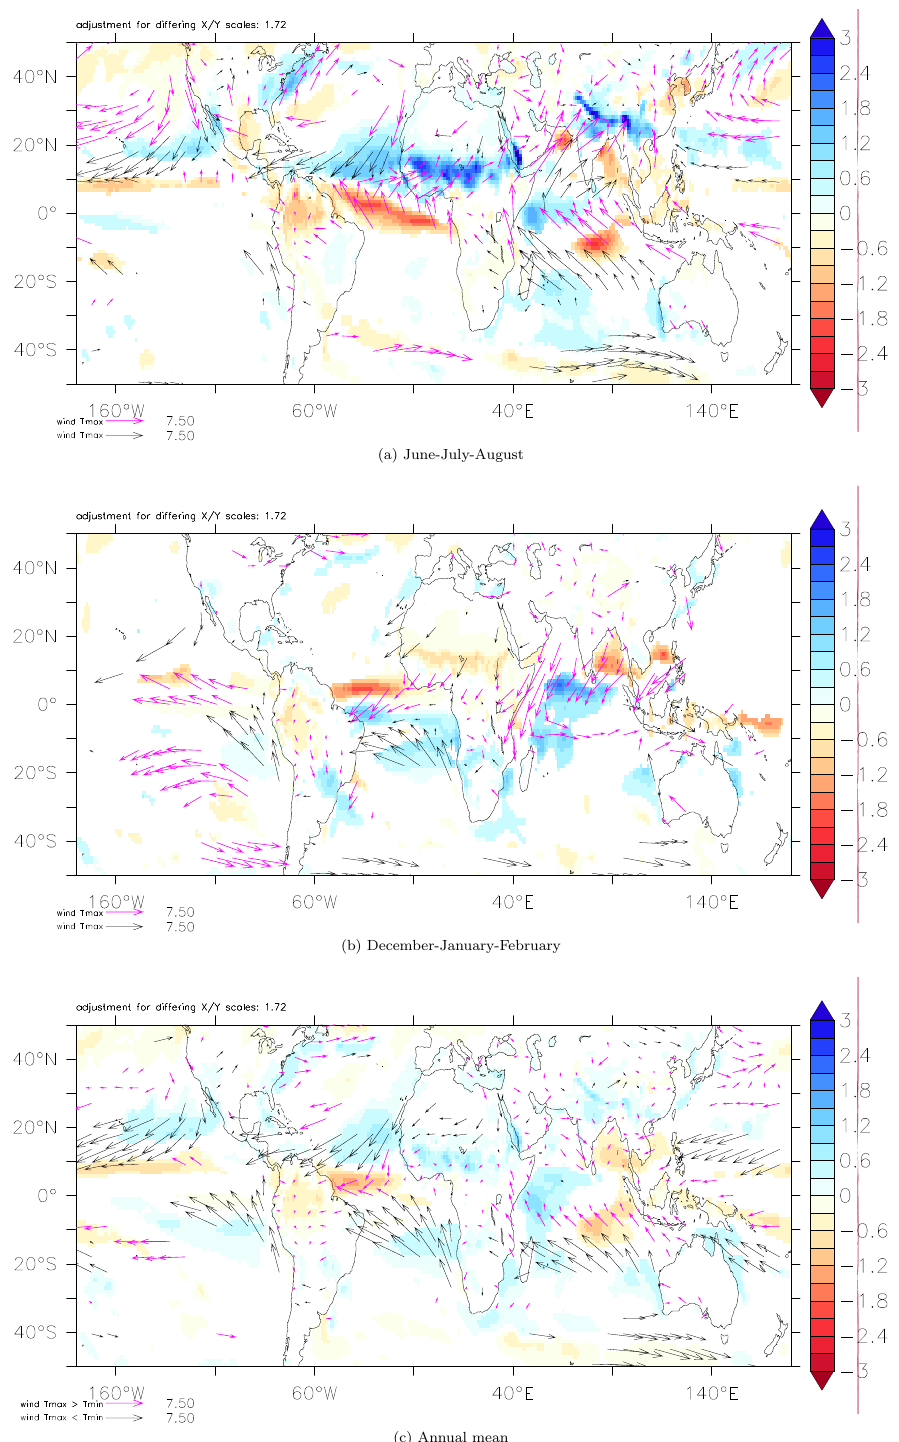
Figure 4. Net precipitation differences and T max surface wind for JJA (a) , DJF (b) and annual mean (c) . For net precipitation (precipitation minus evaporation), the differences ( T max minus T min ) are shown in mmday − 1 . Overlain are the wind vectors for T max in ms − 1 . Purple vectors indicate larger wind speeds during T max than during T min . Cross-equatorial winds are stronger in JJA (a) and DJF (b) , mostly over the Atlantic and Indian Ocean. Every seventh arrow in the x direction is drawn and every fourth arrow in the y direction. Results are only shown where the differences in net precipitation or wind speeds are statistically significant at 95% (based on a two-sided Student t test). The full wind field is given in Fig.